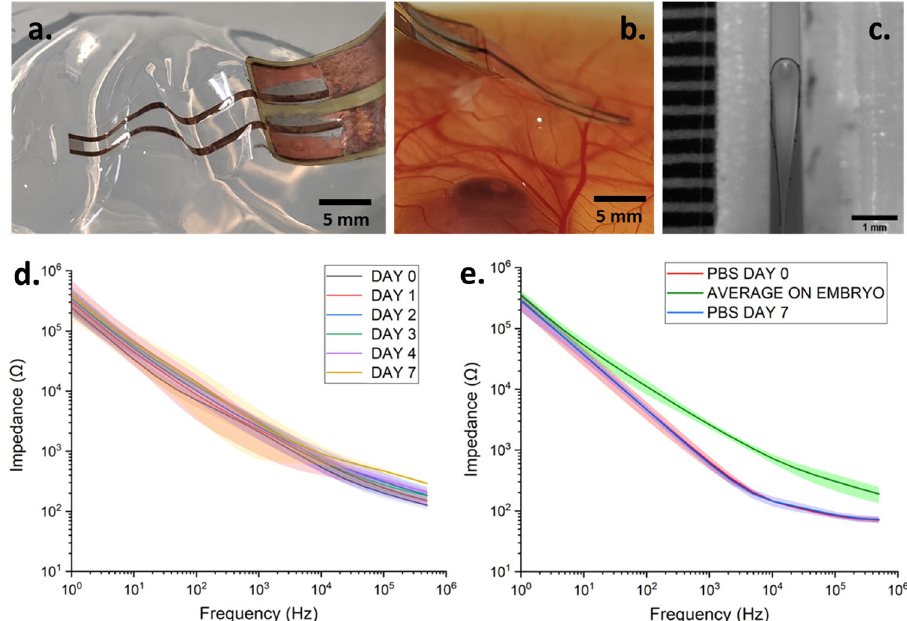
Fig. 2 Mechanical and electrical characterization of fl exible electrodes. a Flexible device placed on the surface of a phantom brain made in 0.6% (w/v) agarose in deionized water. b Flexible device sticking to the CAM. c Flexible device bended between two jaws, with a bending radius of 0.2 mm. d Electrochemical impedance spectroscopy of the fl exible interdigitated electrodes in situ over time. DAY 0 to 2: N = 5, DAY 3 and 4: N = 4, DAY 7: N = 2). e Impedance spectroscopy in vitro in PBS, before and after the experiment, and the average impedance in situ. N = 5. Error bars indicate standard deviations. Scale bars: a , b 5 mm, c 1 mm.